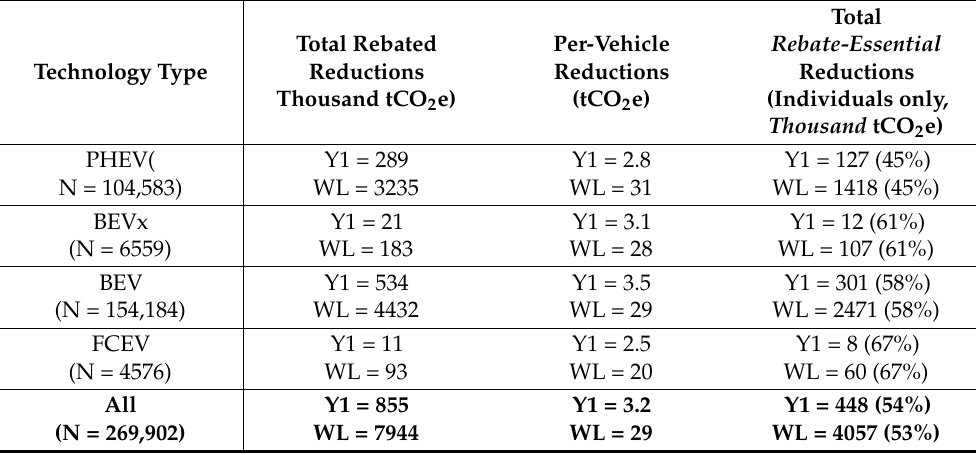
Table A4. GHG Reduction Estimates by Technology Type and Quantification Period.